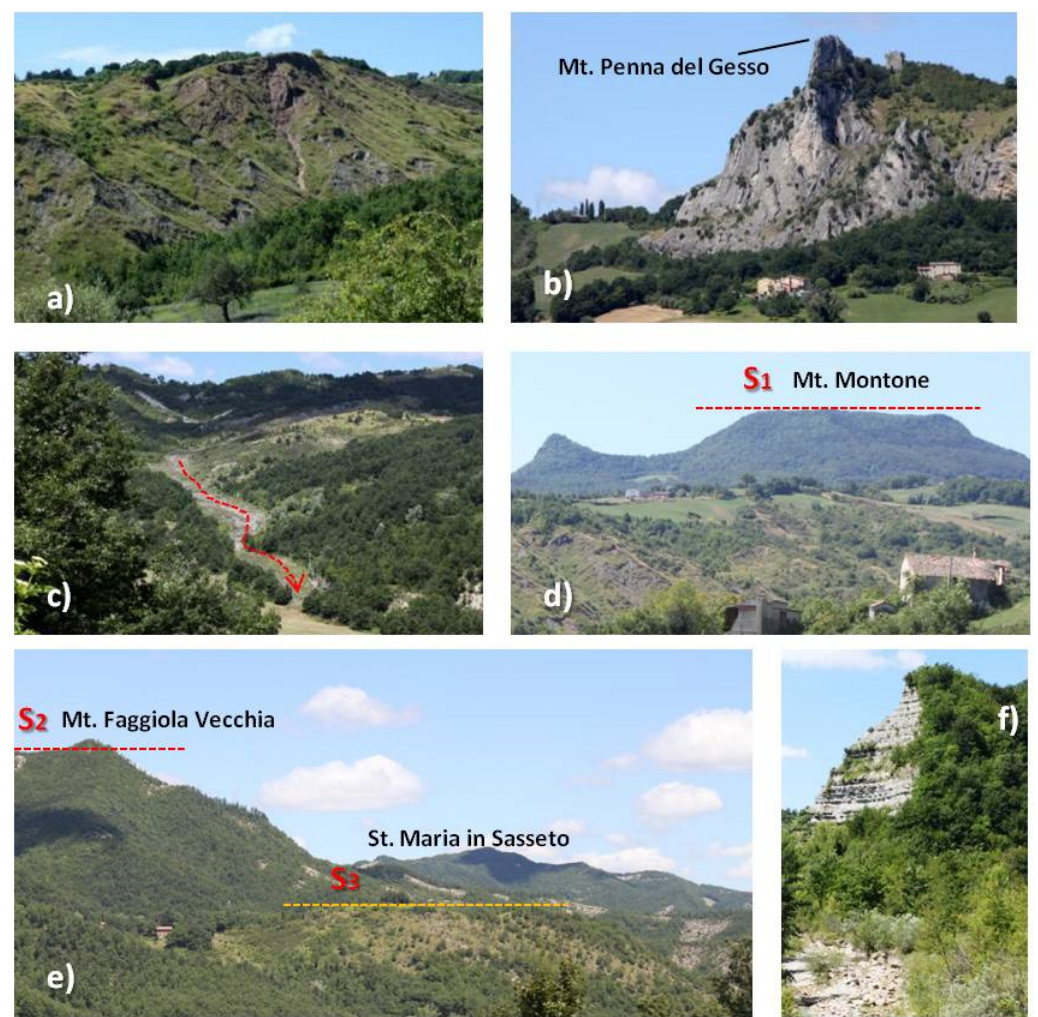
Figure 3. Some examples of landforms and geomorphological processes in the two analyzed river basins. Legend: ( a ) Badlands and shallow landslides near St. Lucia (Mazzocco valley); ( b ) Mt. Penna del Gesso (Mazzocco valley); ( c ) debris-flow near Casteldelci (Senatello Valley) and flow direction in red; ( d ) S1 paleosurface of Mt. Montone (Mazzocco valley); ( e ) S2 and S3 paleosurfaces of Mt. Faggiola Vecchia and St. Maria in Sasseto (Senatello valley); ( f ) Casteldelci cliff and Senatello riverbed (Senatello valley).